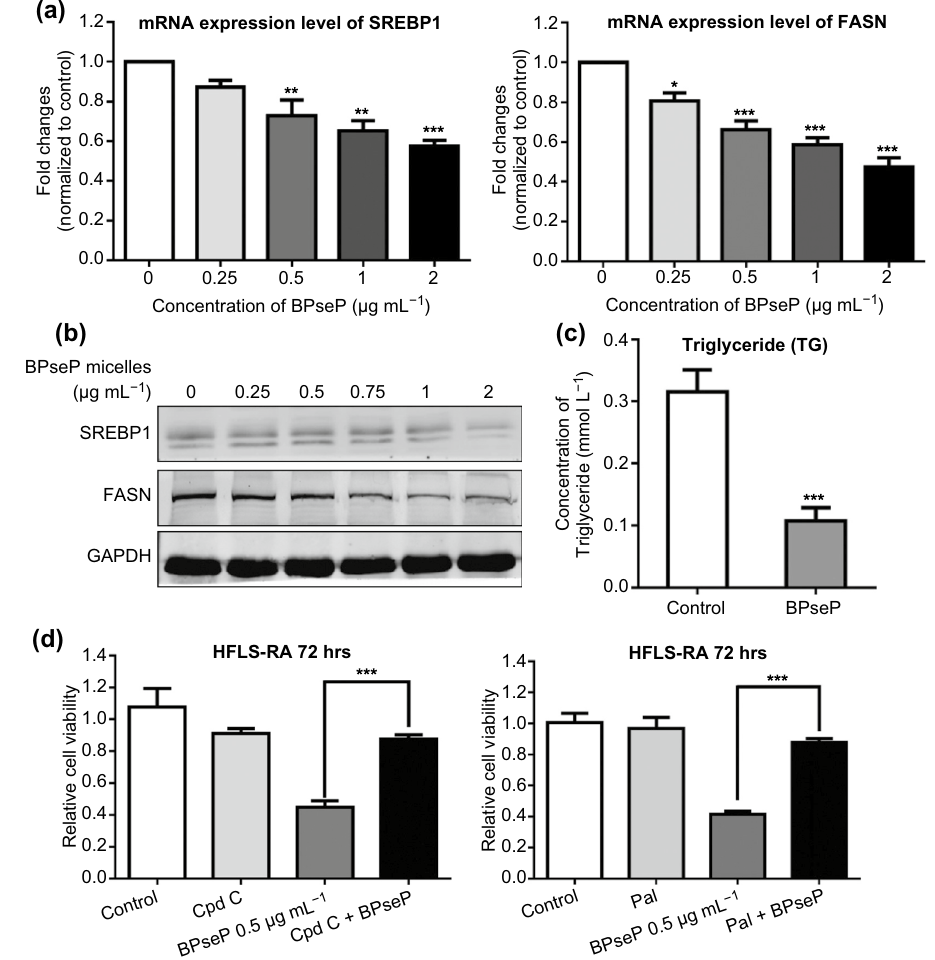
Fig. 6 a , b SREBP1 and FASN were significantly down‑regulated by the treatment of BPseP. c The cellular level of TG was decreased. d AMPK inhibitor compound C and palmitic acid (the key intermediator of lipogenesis) partially counteract the suppressive effect of BPseP. Data were analyzed as the mean ± SEM for triplicate individual experiments (* P < 0.05, ** P < 0.01, *** P <